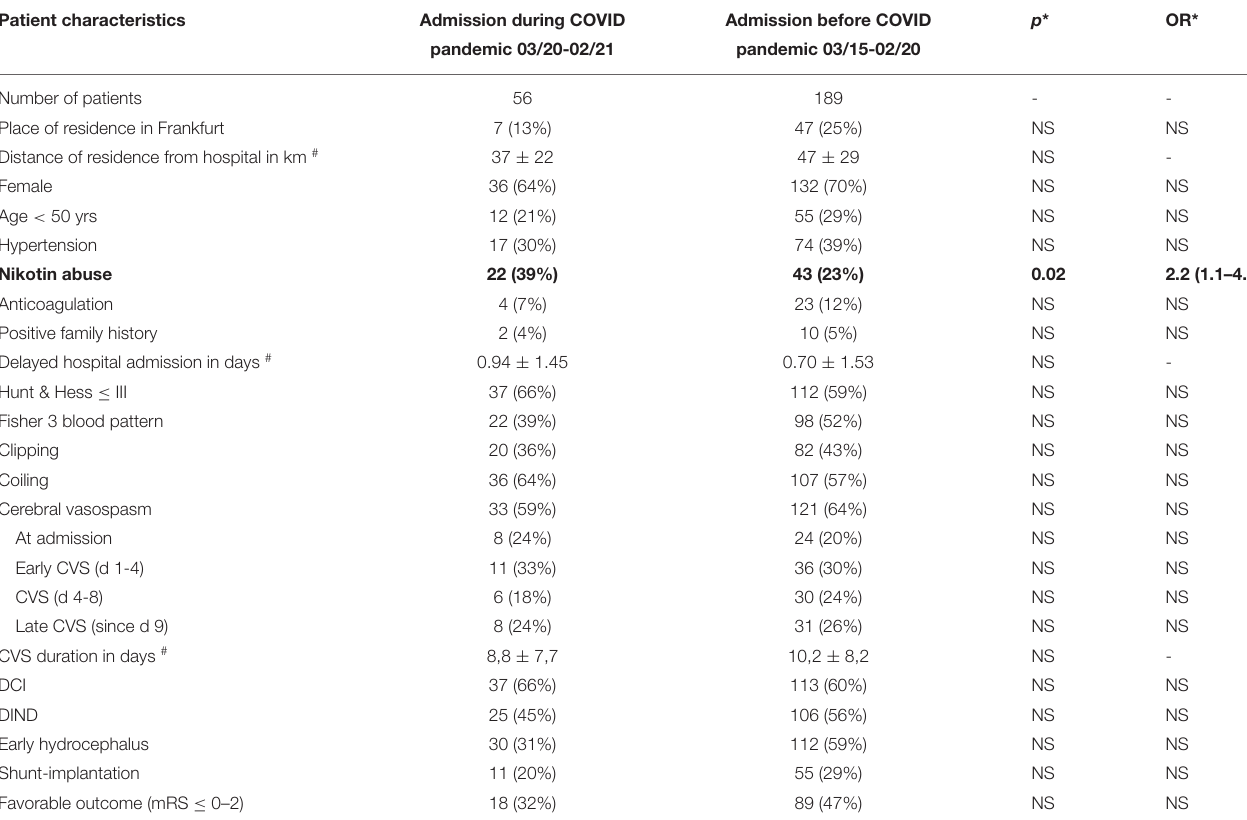
TABLE 2 | Characteristics of patients with aSAH during 1 year of COVID-19 pandemic (03/20-02/21) vs. the 5 pre-pandemic years (03/15-02/20) in Frankfurt am Main, Germany. Patient